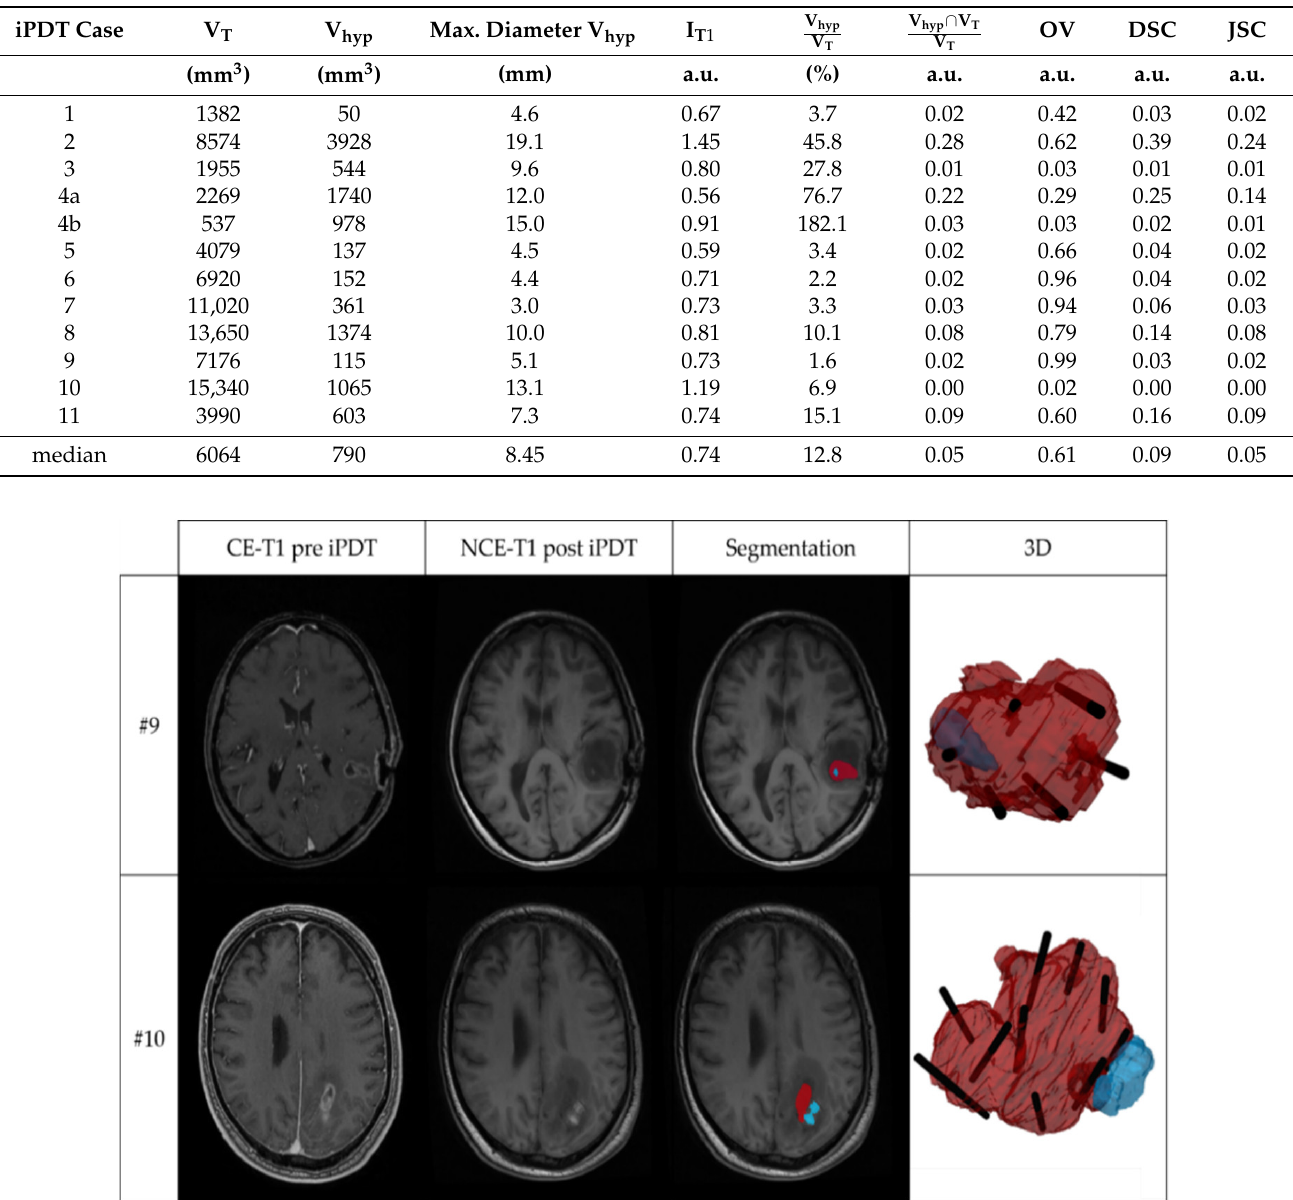
Table 2. Tumor volume (V T ) and properties of the intrinsic T1 hyperintensity volume (V hyp ) of the different iPDT cases and the calculated Overlap (OV), Dice (DSC), and Jaccard (JSC).